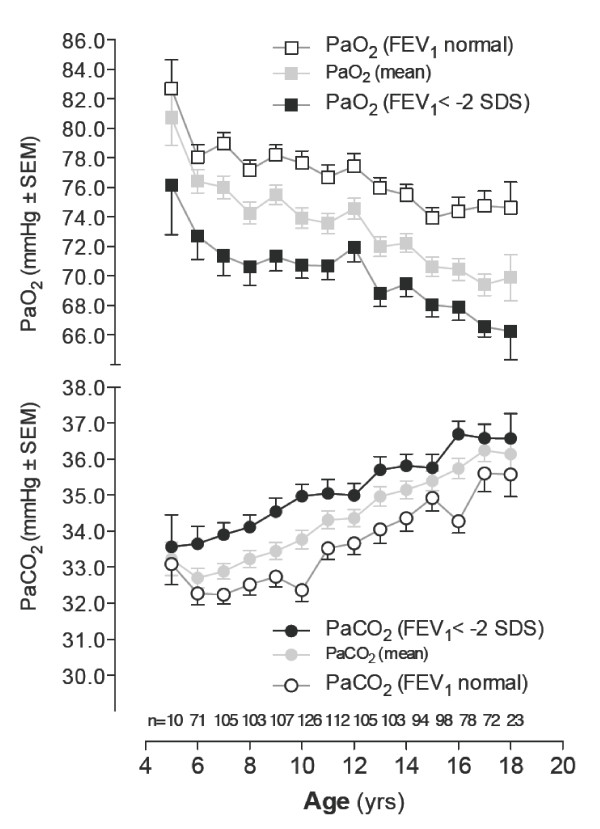
Annual changes of gas exchange characteristics (PaO2, PaCO2) shown as mean ± SEM of repeated annual measurements over the age range 5 to 18 years (halftone symbols), stratified into measurements concomitantly obtained under normal FEV1 > -2 SDS (open symbols) and abnormal, FEV1 < -2 SDS solid symbols. Measurement numbers (n) are given along the x-axis.